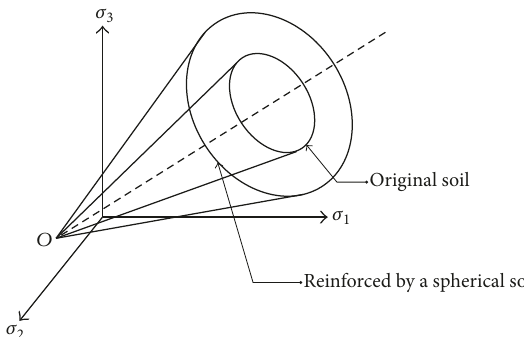
Figure 4: Yield surface of a spherical volume of soil reinforced by a PP woven